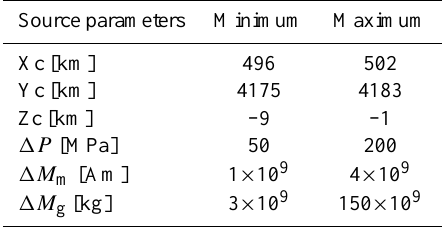
Fig. 1. Mesh of the computational domain. The mesh has a spa- tial resolution of 300m in the summit area and around the source location and becomes coarser at greater distance. Table 1. Ranges of the random generated parameters of the